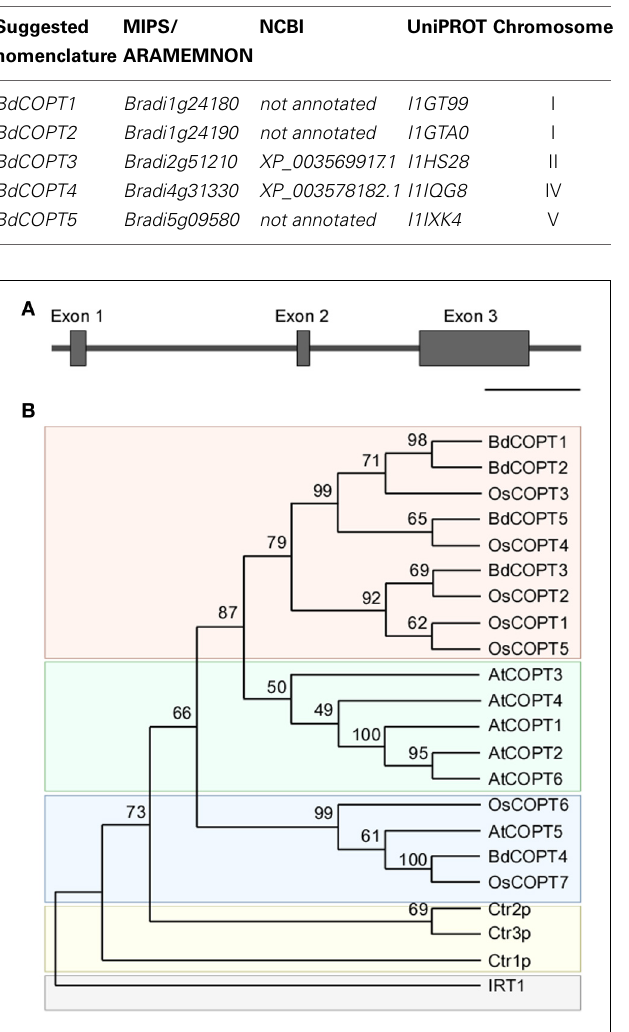
FIGURE 1 | Gene structure of BdCOPT2 and phylogenetic analysis of the brachypodium COPT family. (A) Gene structure of BdCOPT2 . Note the presence of introns, which are absent in other plant CTR/COPT members. Scale bar = 500bp. (B) A phylogenetic tree of CTR/COPT members of A. thaliana (designated as AtCOPT1-6), O. sativa (designated as OsCOPT1-7), brachypodium (designated as BdCOPT1-5), and